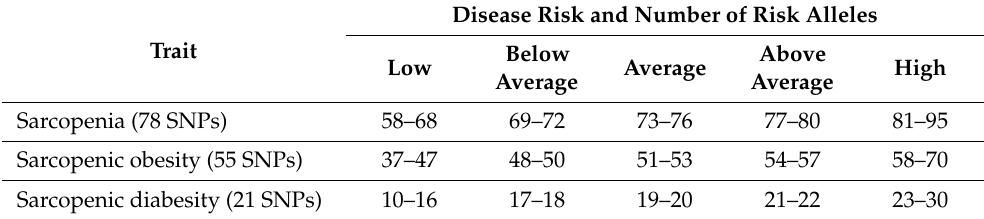
Table 3. Stratification of European individuals by the number of risk alleles. Trait